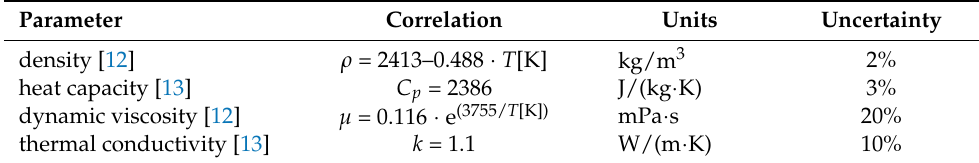
Table 1. Material properties of